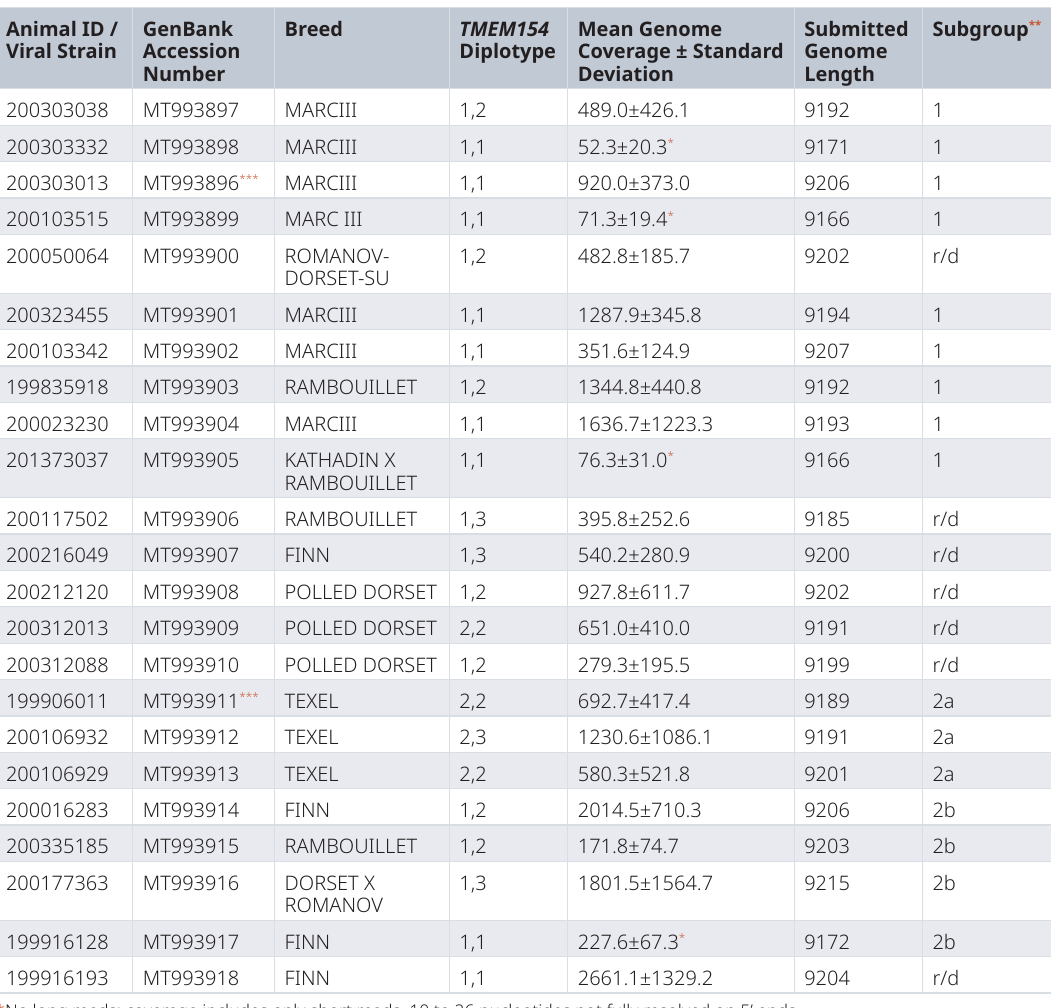
Table 1. Sheep and virus information for 23 SRLV A2 strains. Animal ID / Viral